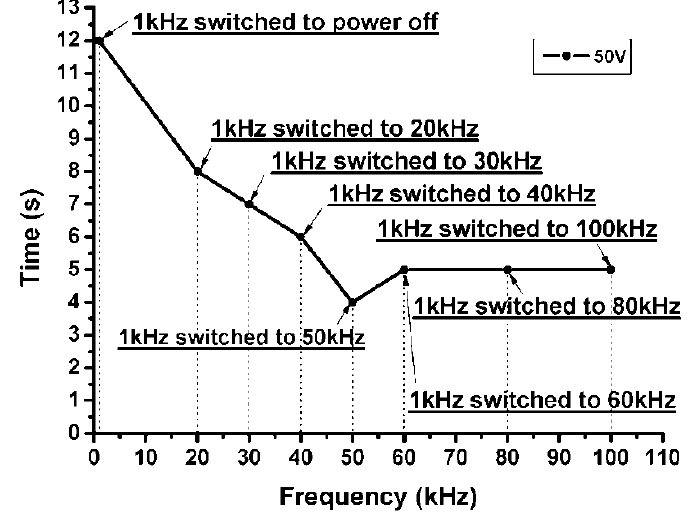
Figure 10. The recovery time of the ring-and-pie type DFLC lens at different driving frequencies.